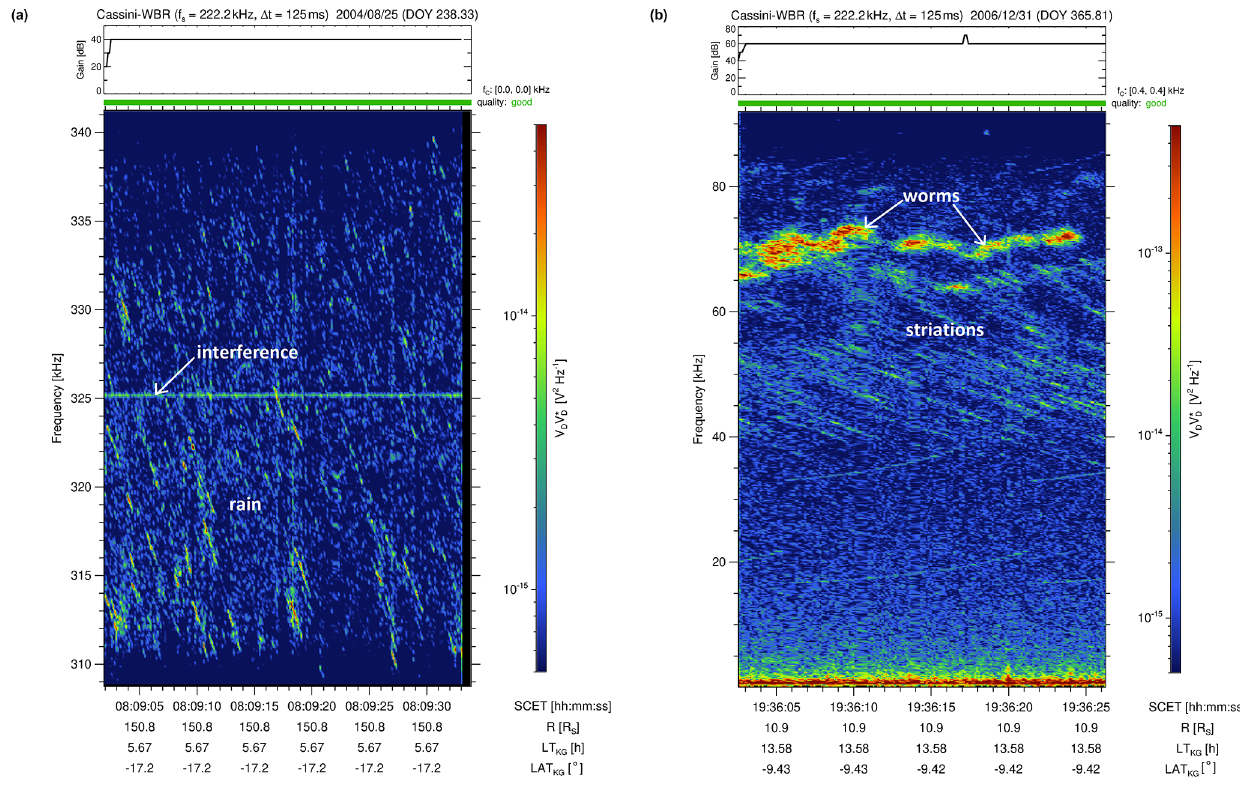
Figure 4. SKR fine structures called “rain” at 325kHz in comparison to “striations” at 80kHz measured by the Cassini WBR. Above 60kHz, the newly defined features called worms can be